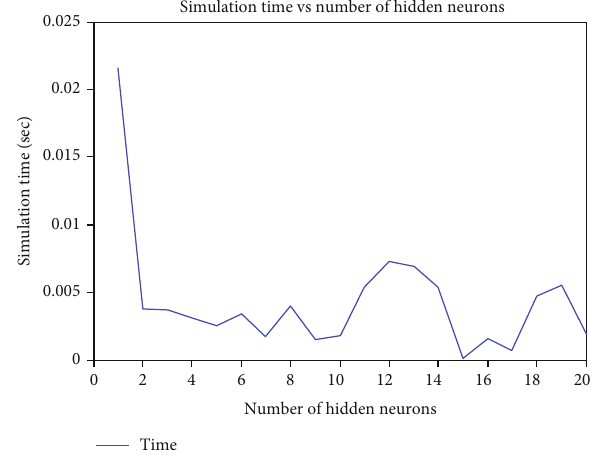
Figure 13: Four input MLPNN-based forecasting model simulation times vs. number of hidden